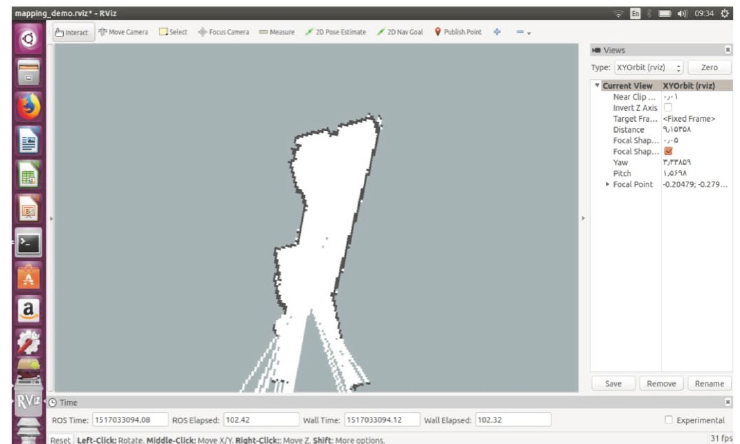
Figure 5: Map Construction by Hector SLAM.